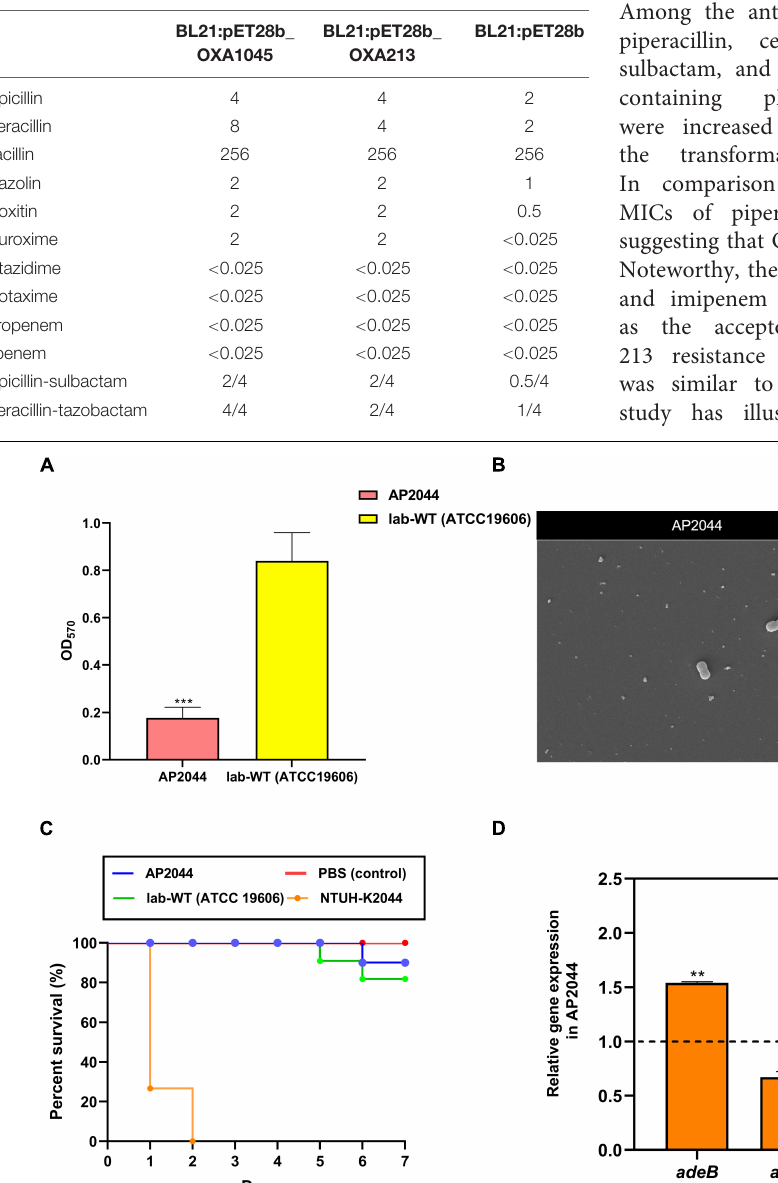
Frontiers in Microbiology |